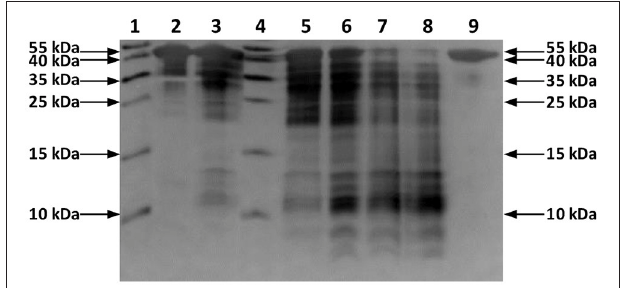
FIGURE 2 | Silver-stained SDS-PAGE gel of OVA in the presence of the Hf1-WD2 POM. OVA (0.02mM) was incubated with 100 equivalents of Hf1-WD2 at 60 ◦ C for up to 7 days in phosphate buffer (10.0mM, pH 7.4). Lanes 1–9 from left to right: protein ladder, OVA and POM immediately after mixing, after 1 day, protein ladder, after 2, 4, 6, 7 days, and OVA only after 7 days.